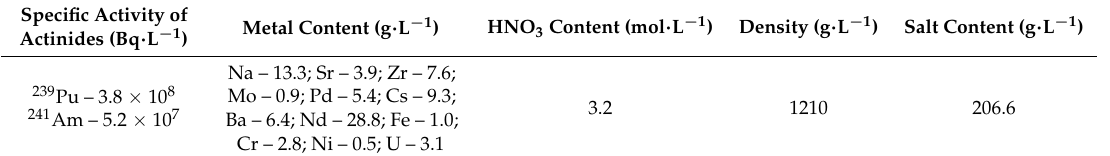
Table 1. Characteristics of high level waste (HLW) surrogate